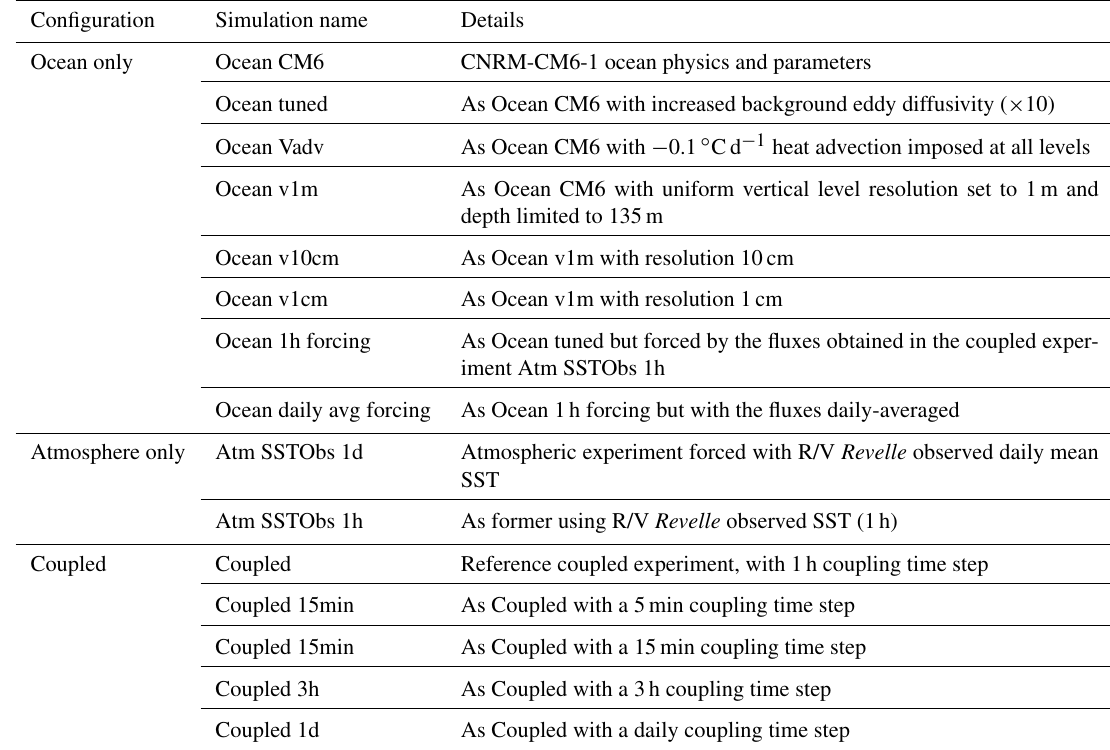
Table 2. List of experiments done with CNRM-CM6-1D for each experiment; the table indicates the components involved and a short